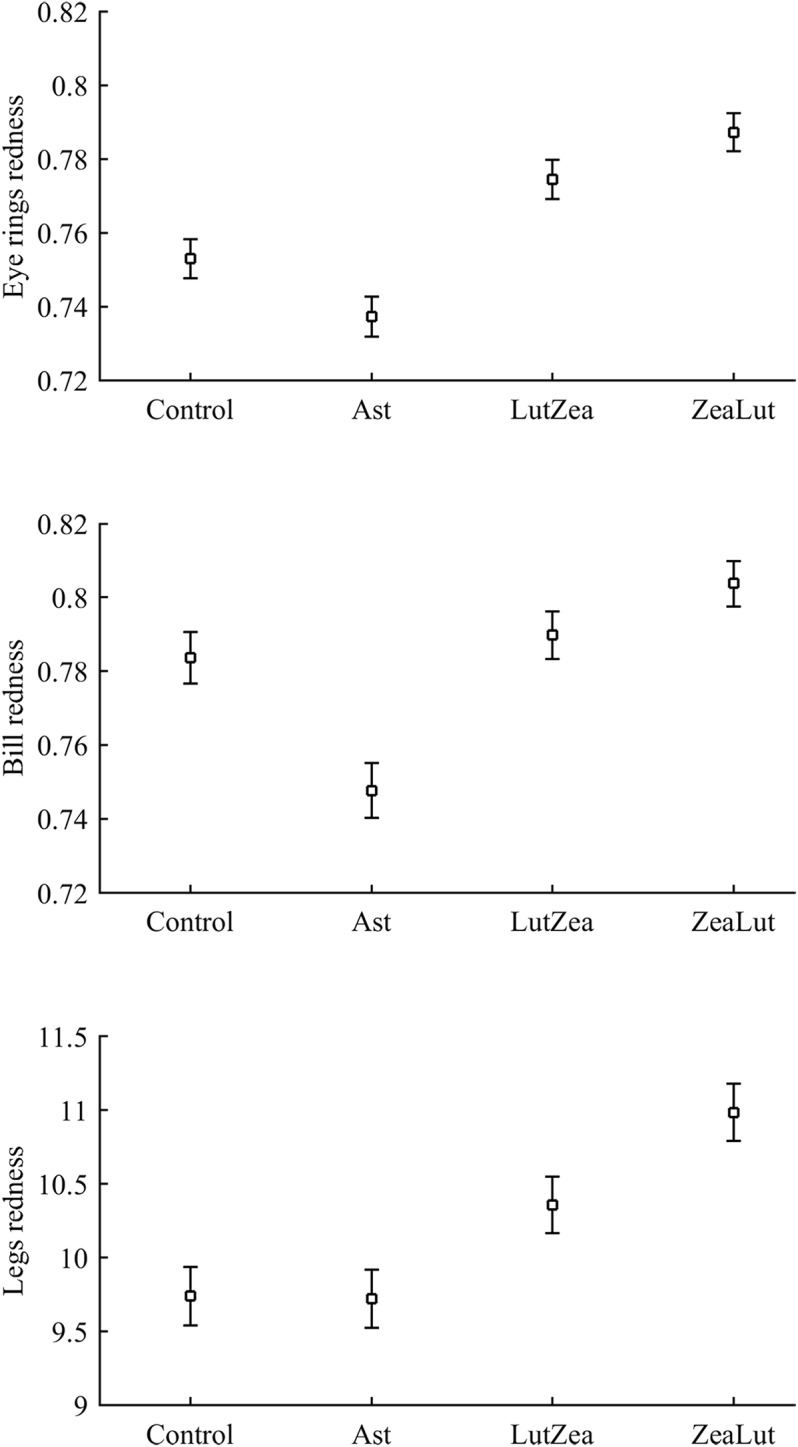
Final values of ornament coloration depending on carotenoid supplements exclusively.Least squared means � SE from the models controlling for the effect of the diquat treatment.